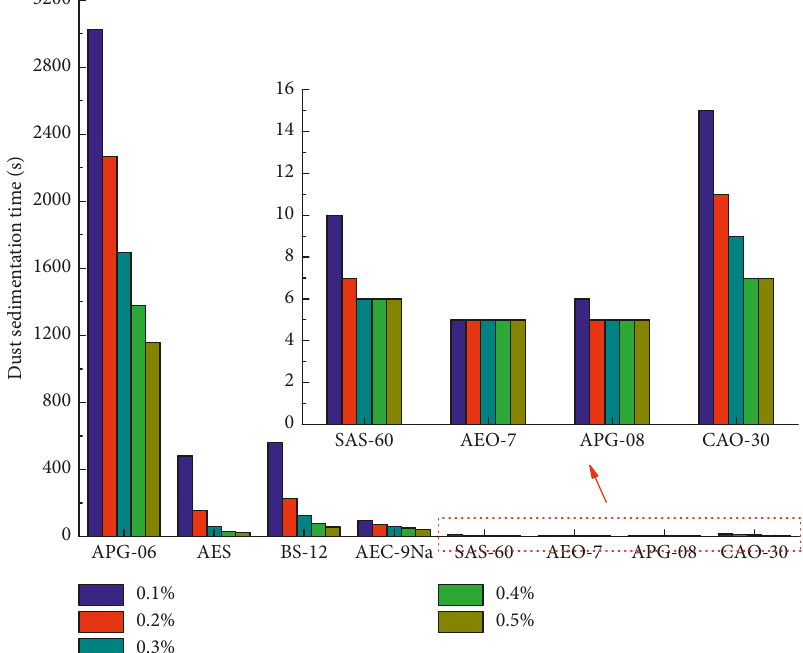
Figure 1: Dust sedimentation times of the different